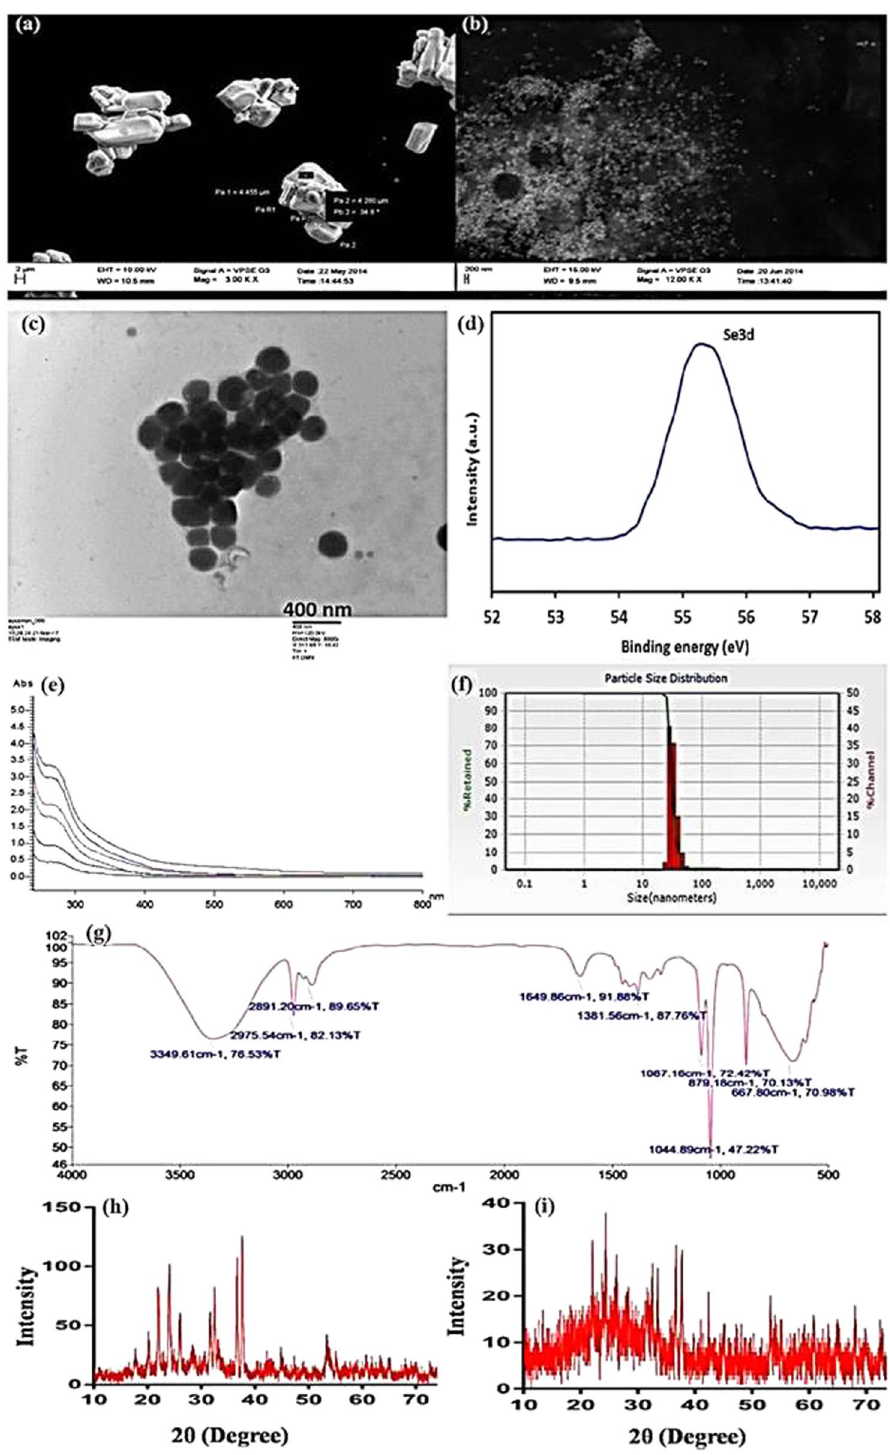
Figure 2. Characterization of Trichogenic-SeNPs generated using culture filtrate of T . asperellum . ( a ) Scanning electron microscopic (SEM) view of commercially available sodium selenite compound. ( b ) Scanning electron microscopic (SEM) view of Trichogenic-SeNPs. ( c ) Transmission electron microscopic (TEM) view of Trichogenic-SeNPs. ( d ) Se3d XPS spectrum. ( e ) UV- Visible spectrum showing the absorption peak at 280 nm. ( f ) Particle size distribution histogram of Trichogenic-SeNPs. ( g ) FTIR spectrum showing the reduction process with different % Transmittance. ( h ) XRD spectrum of the sodium selenite. ( i ) XRD spectrum showing the presence of